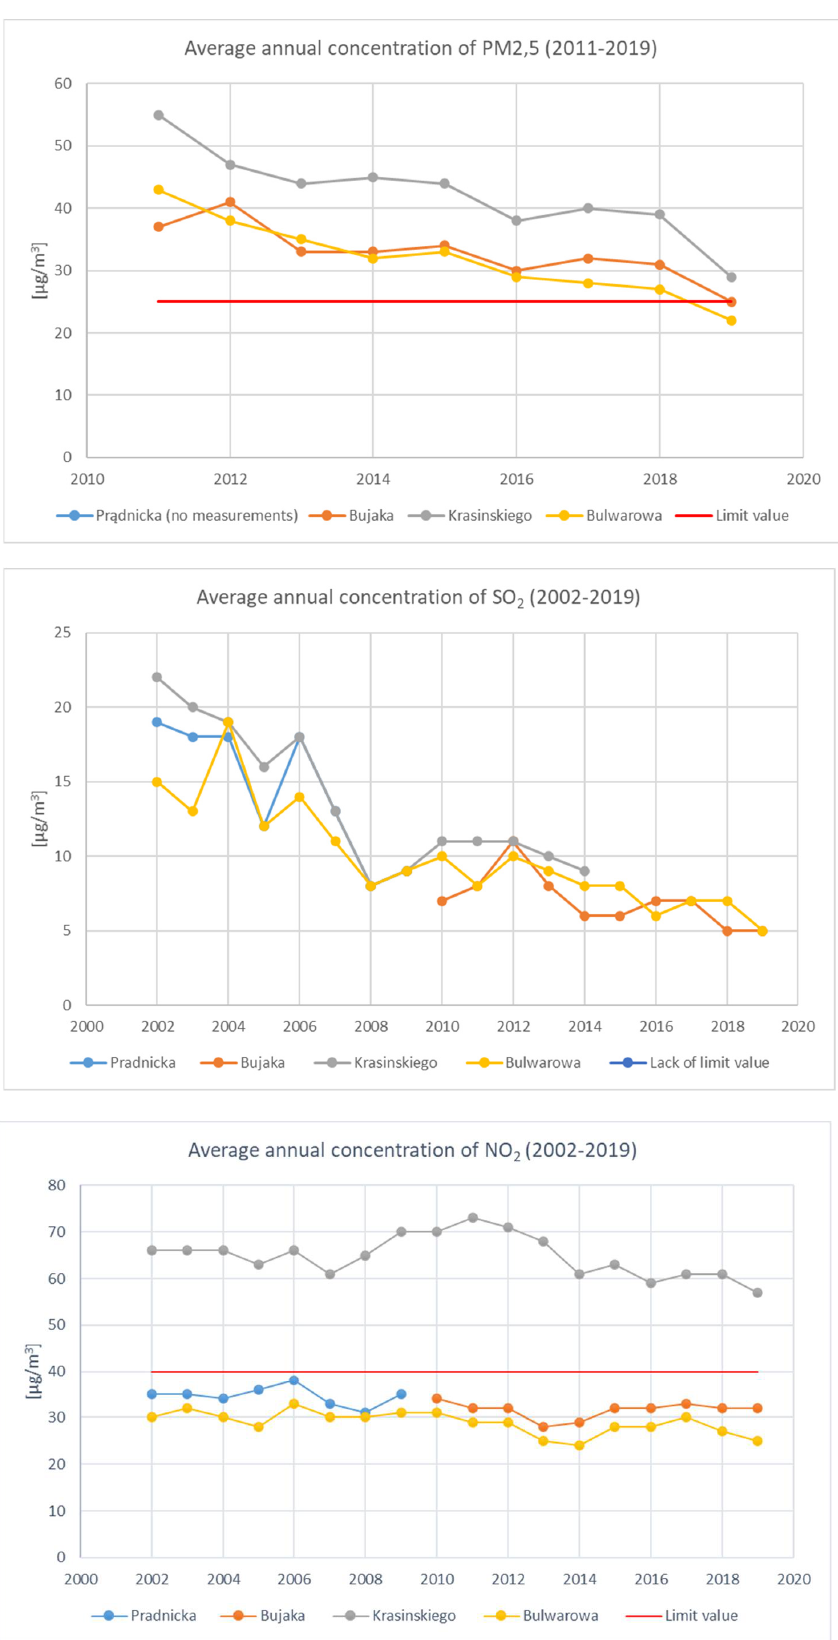
Figure 3. Average annual concentration of air pollutants in Kraków in 2011–2019 (based on the State of the City Reports 2001–2019).